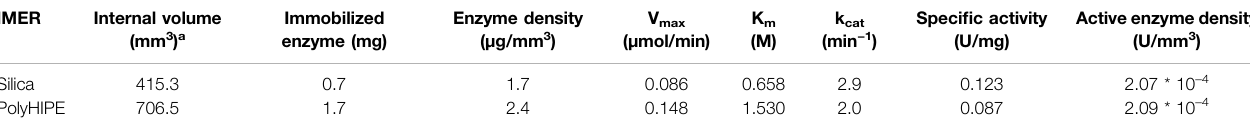
TABLE 3 | Main features of the silica- and